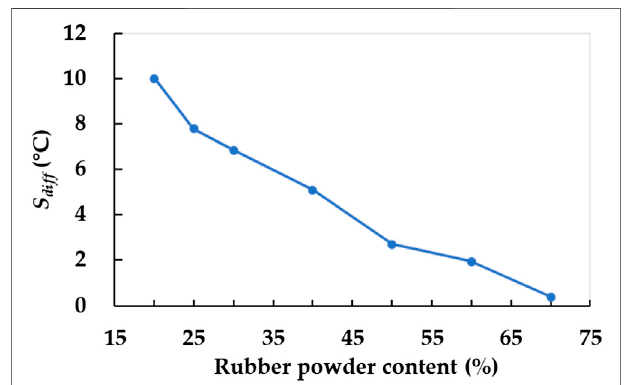
FIGURE5| Variationofsoftening-pointdifferenceofasphaltmodi fi edby high-content activated rubber powder with shear